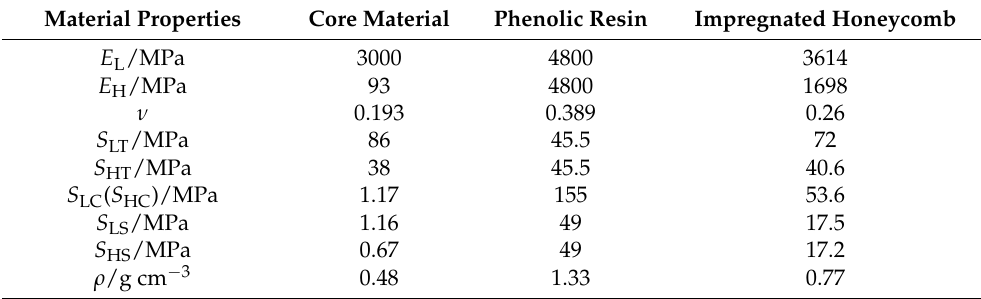
Figure 2. Aramid honeycomb specimen of the cutting experiment. Table 3. Materialpropertiesofthecorematerial[23–26],phenolicresin[13,25,27],andimpregnated